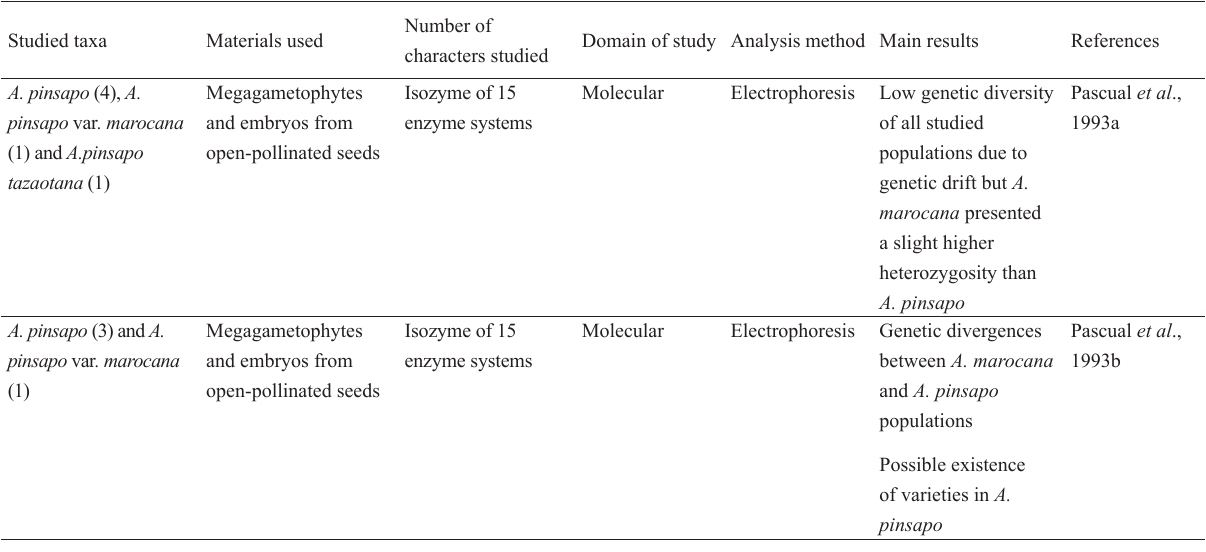
Table 2. Studies which investigated phylogenetic relationships between A. marocana and A. pinsapo . The number of populations sampled is given between brackets after each taxa. Nomenclature used for taxa is that adopted by